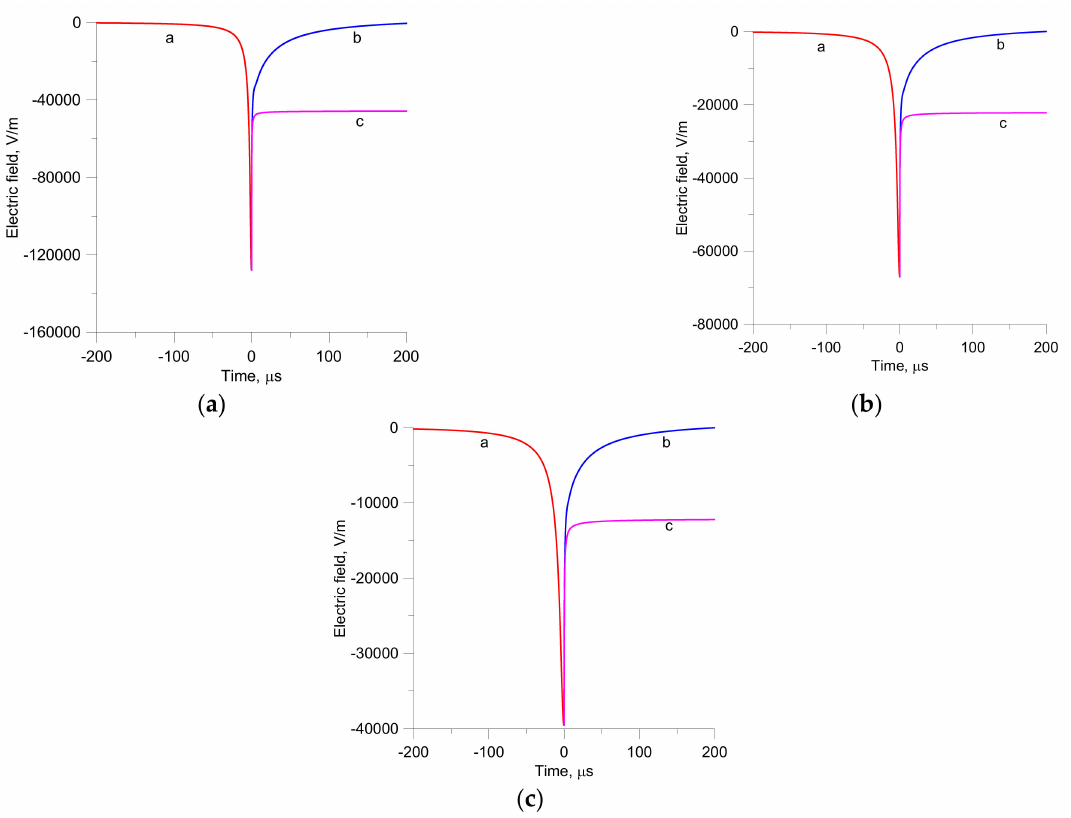
Figure 17. The dart leader-return stroke fields corresponding to ( a ) 15 m, ( b ) 30 m, and ( c ) 50 m from the lightning strike. The curve ‘a’ corresponds to the leader field. The curve ‘b’ corresponds to the return stroke field in the absence of current reflection and the curve ‘c’ corresponds to the return stroke field when the current reflection is included in the model. In the diagrams, the time zero corresponds to the initiation of the return